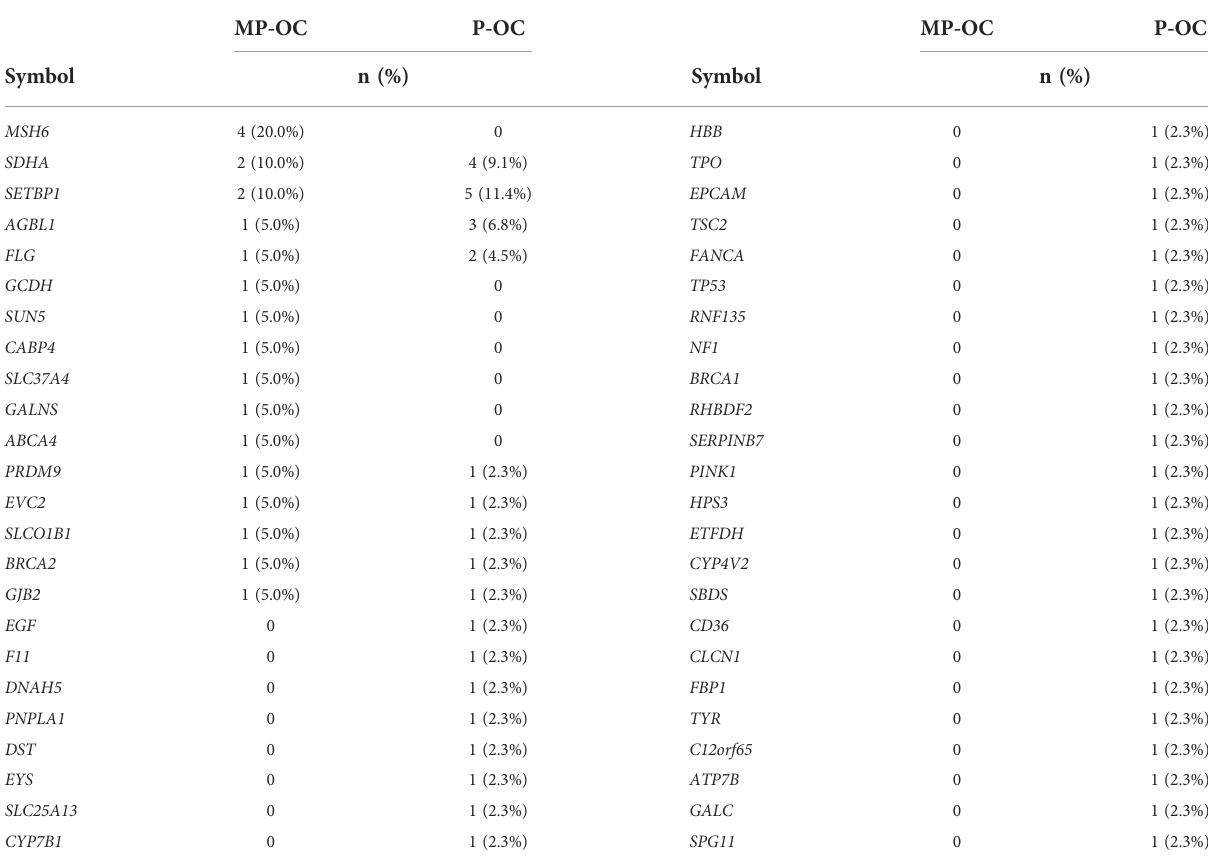
TABLE 3 Germline mutations in MP-OC and P-OC